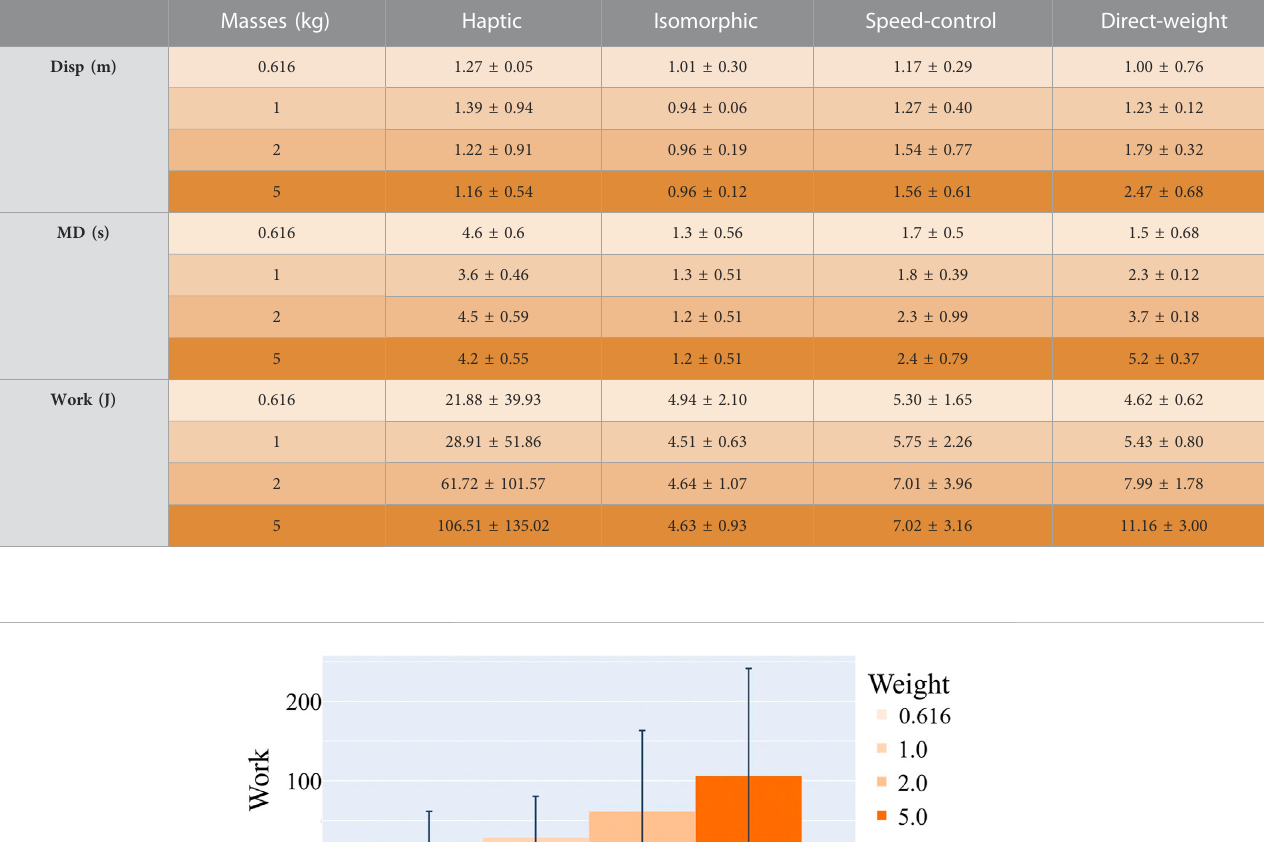
TABLE 1 Kinematic features and physical work of weight lifting movement with different masses in virtual reality.